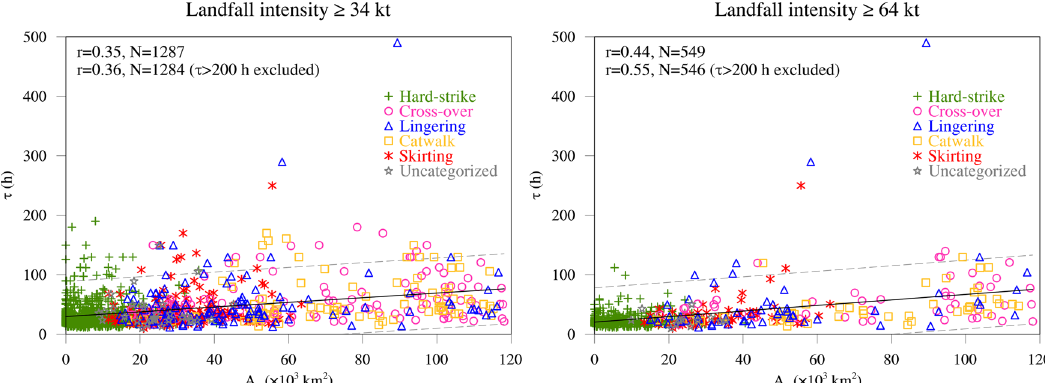
Fig. 3 Global landfalling tropical cyclone track modes, effective area of moisture supply from the ocean A o , and decay. Scatter plots of event-level τ versus A o of tropical cyclones with landfall intensity ≥ 34 kt and ≥ 64 kt are shown in left and right panels, respectively. Corresponding correlations r and number of events N are provided. Linear regression lines (solid lines), and their corresponding 95% prediction bands (dash lines) derived from all events are